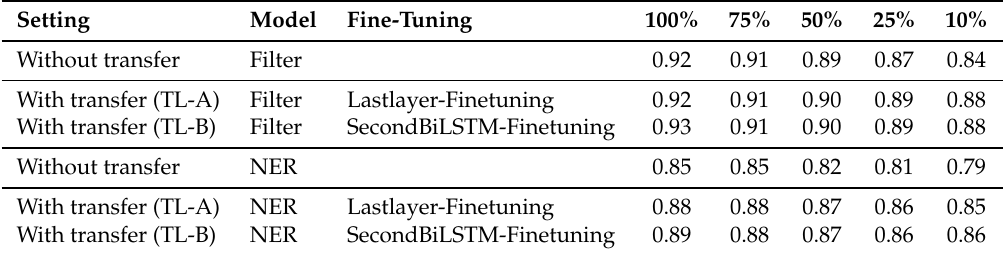
Table 7. Expiration date to invoice date : F1 score of recognition of invoice date in the test set by transfer learning from base model trained with expiration date labels. Results at different levels of freezing trained with different percentages of labeled target data are